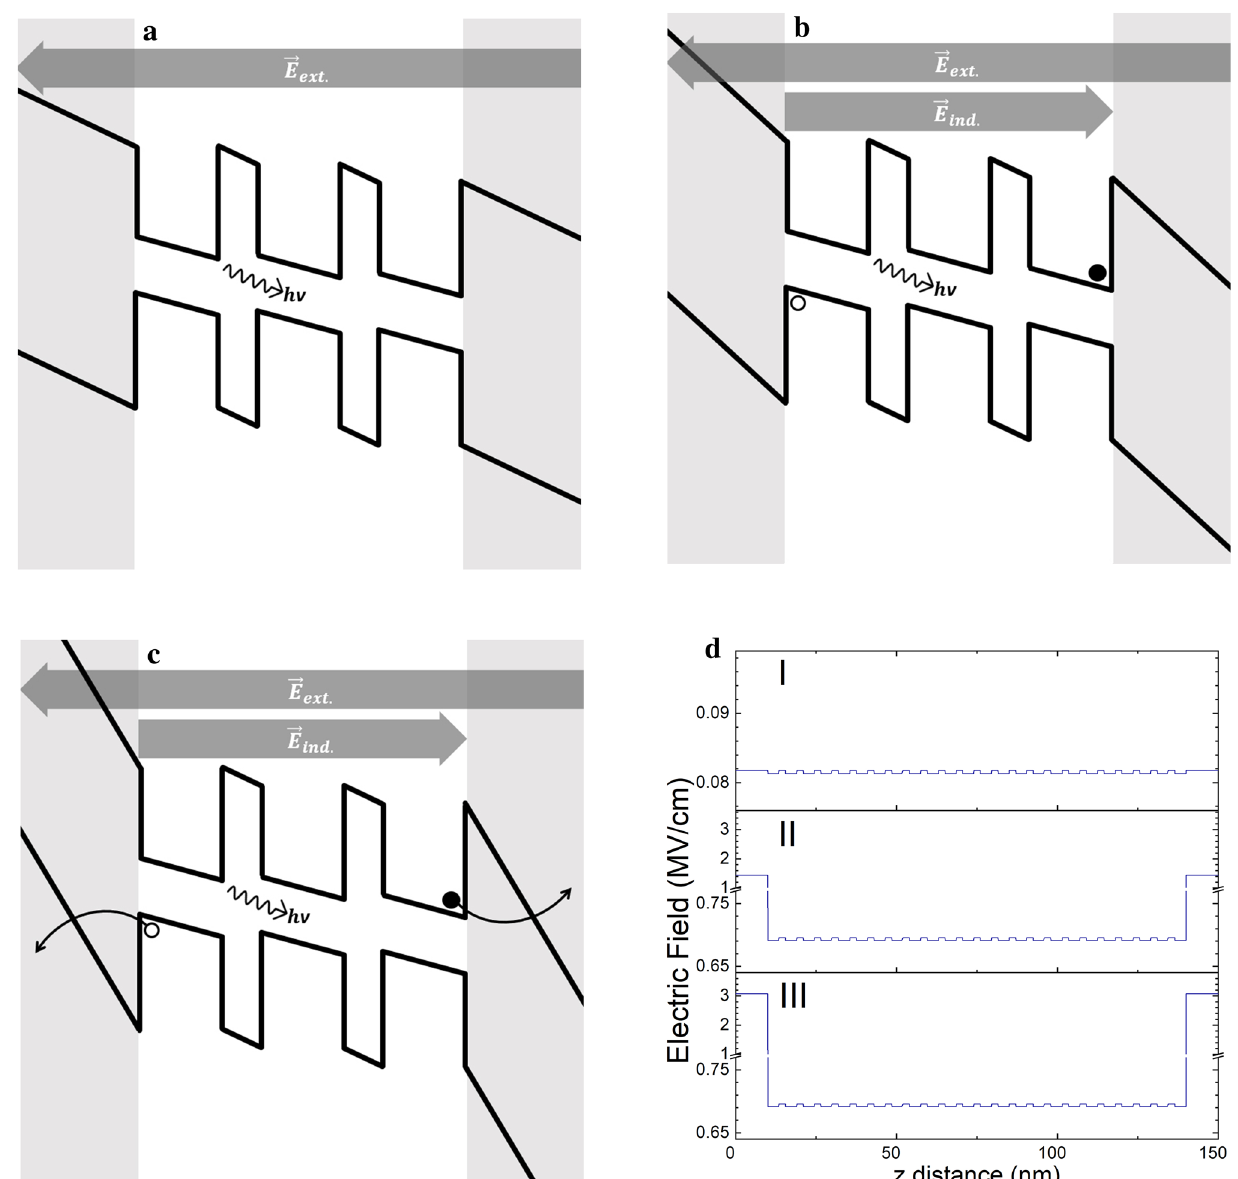
Figure 8. Band structure diagrams across a sample with 2 nm inter-layer-oxide barriers at average external field magnitudes of 0.1 MV/cm ( a ), 1.0 MV/cm ( b ) and 2.0 MV/cm ( c ), with corresponding plots of modelled effective local fields ( d )- I , ( d )- II and ( d )- III plotted as a function of the distance “z” from substrate